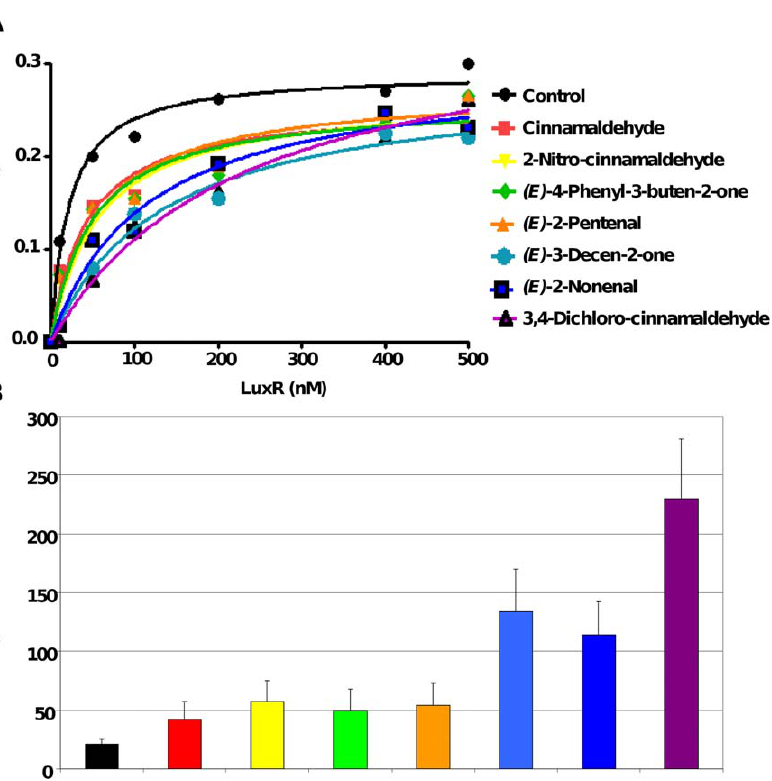
Figure 2. LuxR DNA binding and dissociation constants. A. DNA binding of LuxR in the absence and presence of cinnamaldehyde or a cinnamaldehyde analog (50 m M). The fractional change in anisotropy, D F/F o , is plotted against the concentration of LuxR (nM). B. K d values are calculated as the half-maximal fractional change in fluorescence anisotropy in the absence and presence of cinnamaldehyde or cinnamaldehyde analogs.